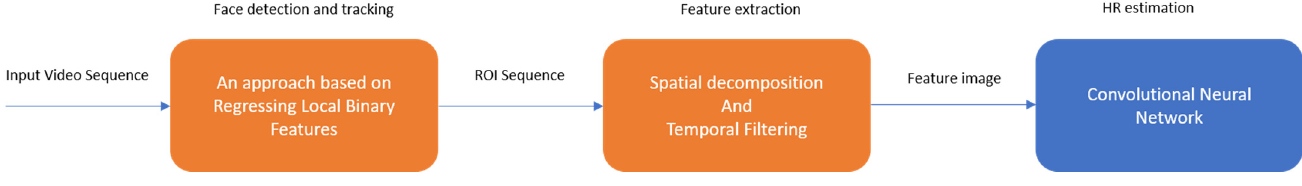
Figure 4. EVM-CNN modules.